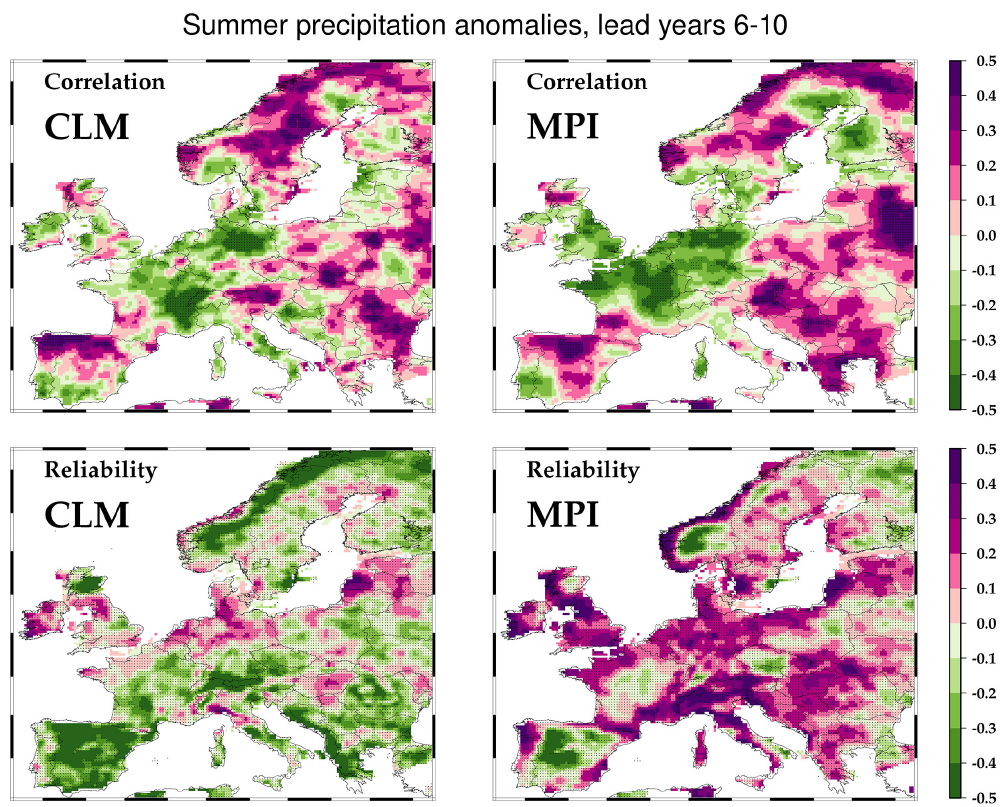
Figure 6. Summer half-year precipitation anomaly sums for lead years 6–10 from 1961 to 2010. The top panels show the correlation coefficient between E-OBS observations and CCLM (left) and MPI-ESM-LR (right). The bottom panels show the reliability of the CCLM (left) and MPI-ESM-LR (right) ensembles with respect to the E-OBS observations. Stippling indicates results, significant at the 10%